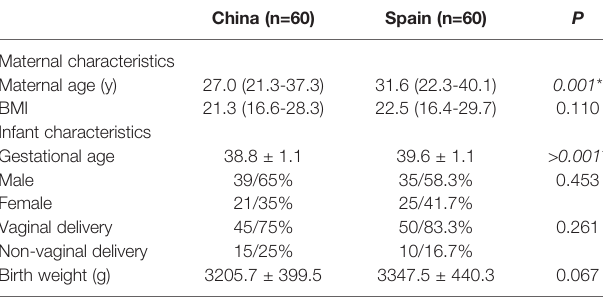
TABLE 1 | The demographic and birth characteristics of subjects from China and Spain.